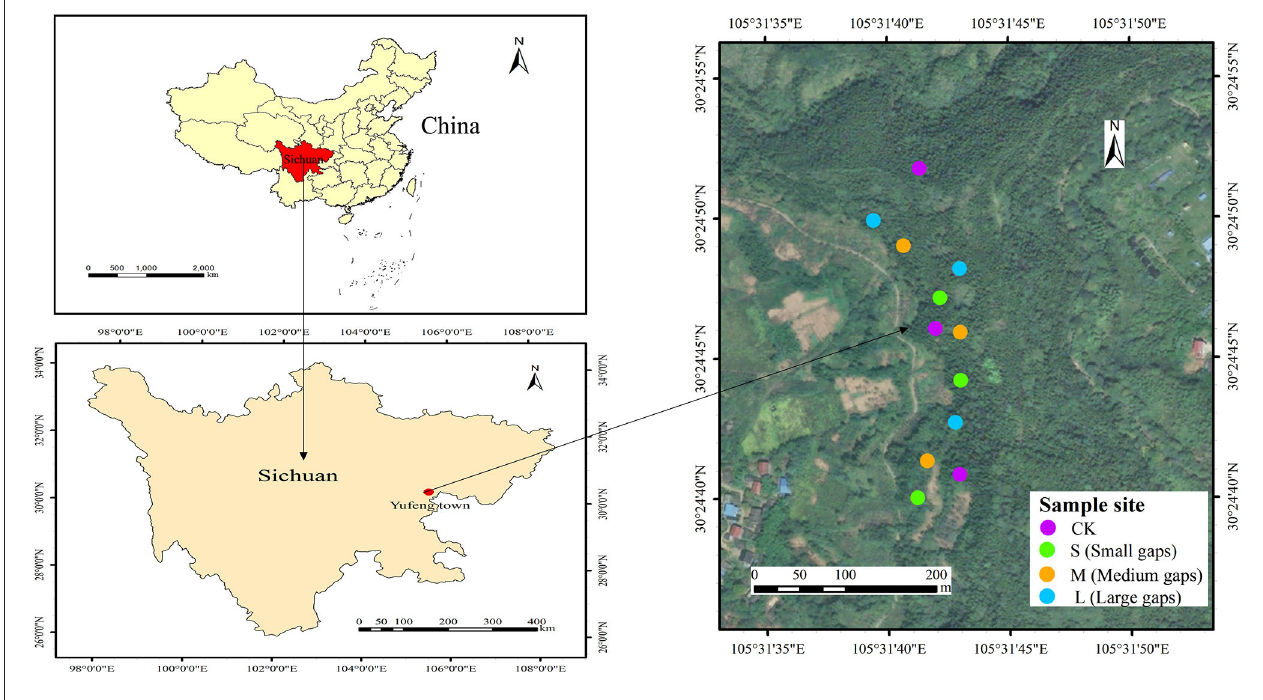
FIGURE 1 | Location of sampling sites in the study area.